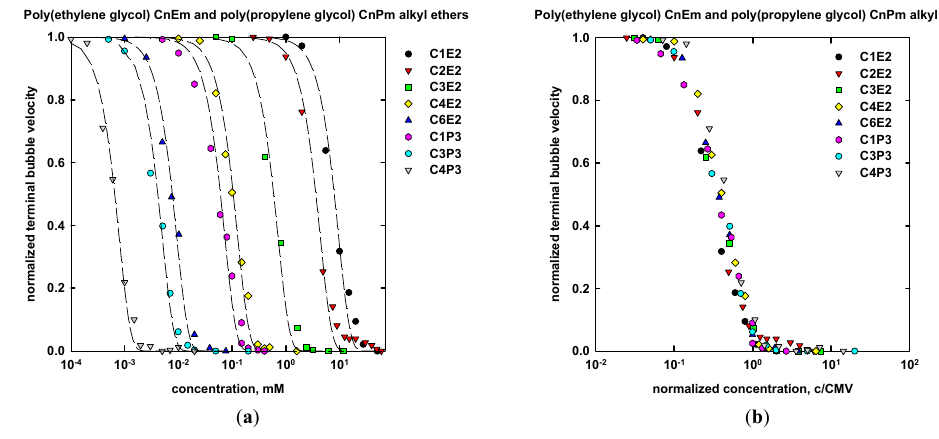
Figure 8. Influence of poly(ethylene glycol) and poly(propylene glycol) alkyl ethers concentration expressed in mM ( a ) and normalized surfactant concentration ( c /CMV) ( b ) on the normalized terminal bubble velocity.